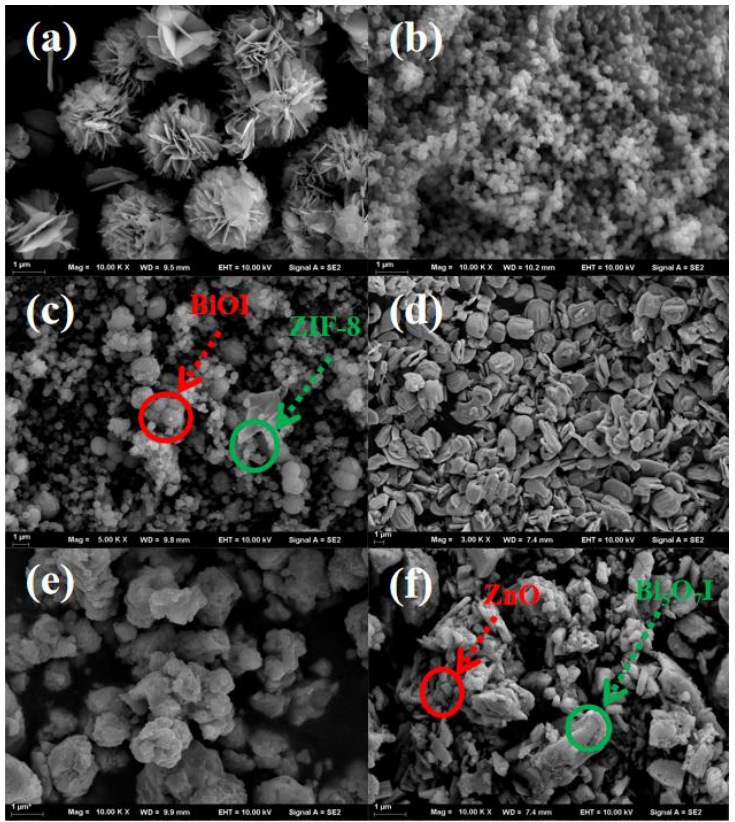
Figure 2. Scanning electron microscope image of ( a ) BiOI, ( b ) ZIF-8, ( c ) ZIF-8@BiOI (2:1), ( d ) Bi 5 O 7 I, ( e ) ZnO, and ( f ) ZnO@ Bi 5 O 7 I (2:1).